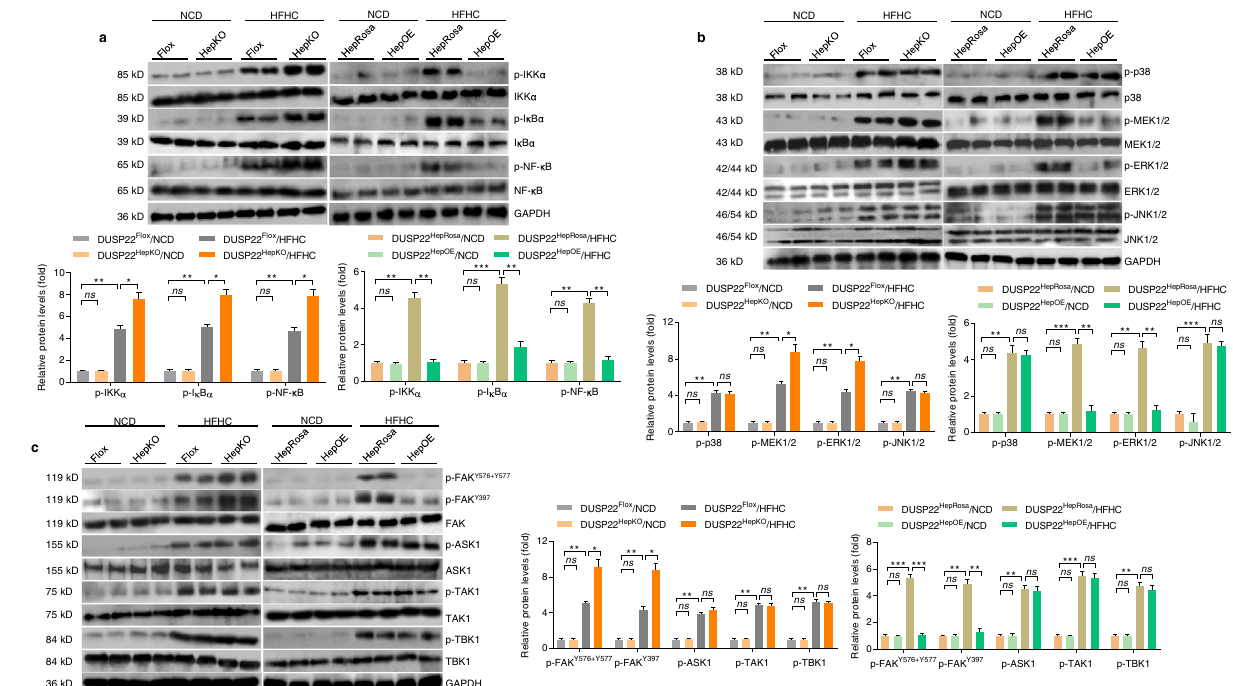
Fig. 4 | DUSP22 regulates the hepatic activation of NF- κ B and FAK signaling in HFHC-fed mice. a Representative western blotting and quanti fi cation of the pro- tein expression of total and phosphorylated IKK α , I κ B α , and NF- κ B in liver of DUSP22 fl ox , DUSP22 HepKO , DUSP22 HepRosa , and DUSP22 HepOE mice fed with a NCD or a HFHCfor24weeks( n =4miceper group)(* P <0.05, ** P <0.01,and *** P <0.001;ns no signi fi cant difference). b Representative western blotting and quanti fi cation of theproteinexpressionoftotalandphosphorylatedp38,MEK1/2,ERK1/2,andJNK1/ 2inliverofDUSP22 fl ox ,DUSP22 HepKO ,DUSP22 HepRosa ,andDUSP22 HepOE micefedwitha